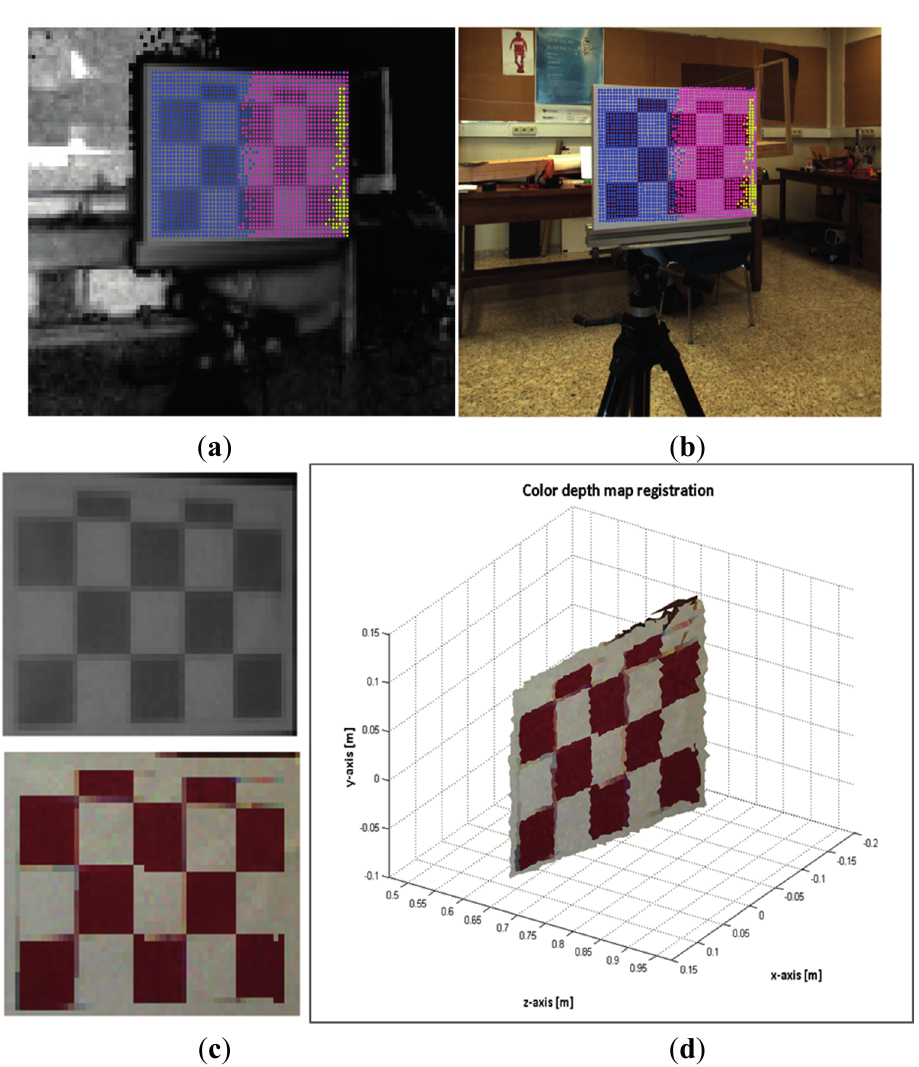
Figure 11. Image sample 19. ( a ) selected points on the ToF; ( b ) estimated points on the RGB image; ( c ) Top: selected ToF ROI. Bottom: estimated RGB ROI; ( d ) colour depth map of the ROI.